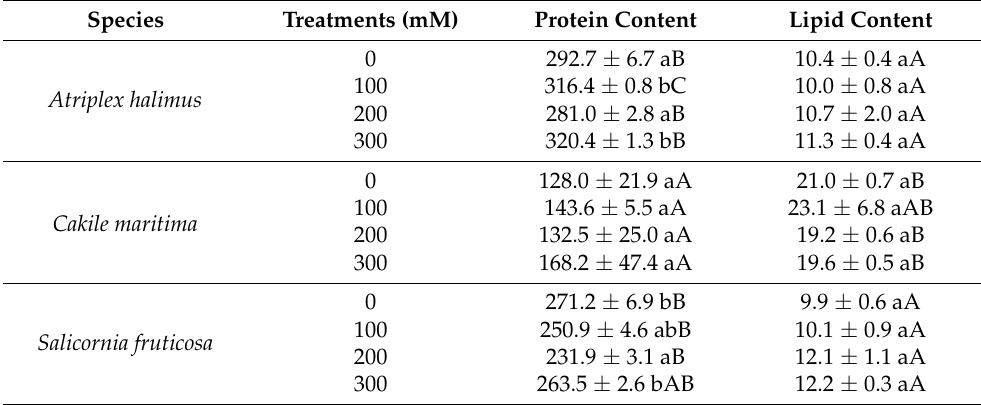
Table 4. Protein and Lipid content in the leaves and stems of Atriplex halimus , Cakile Maritima ,